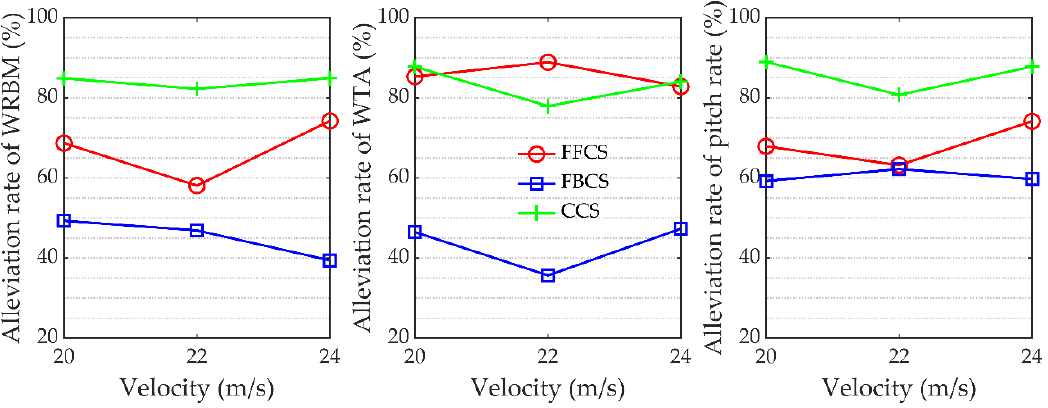
Figure 23. Gust alleviation rates of three control systems (gust frequency is 2.0 Hz).